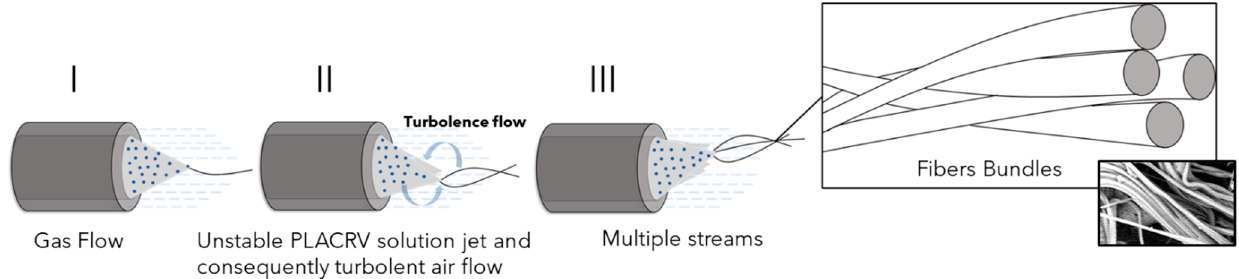
Figure 4. Pictorial representation of the formation of fibers bundles during SBS process.